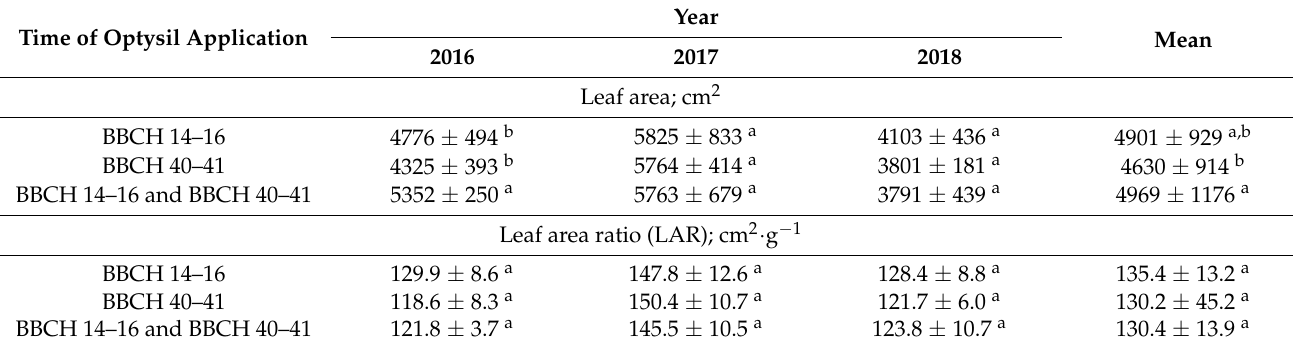
Table 6. Effect of time of Optysil application on leaf area and leaf area ratio (LAR). Time of Optysil